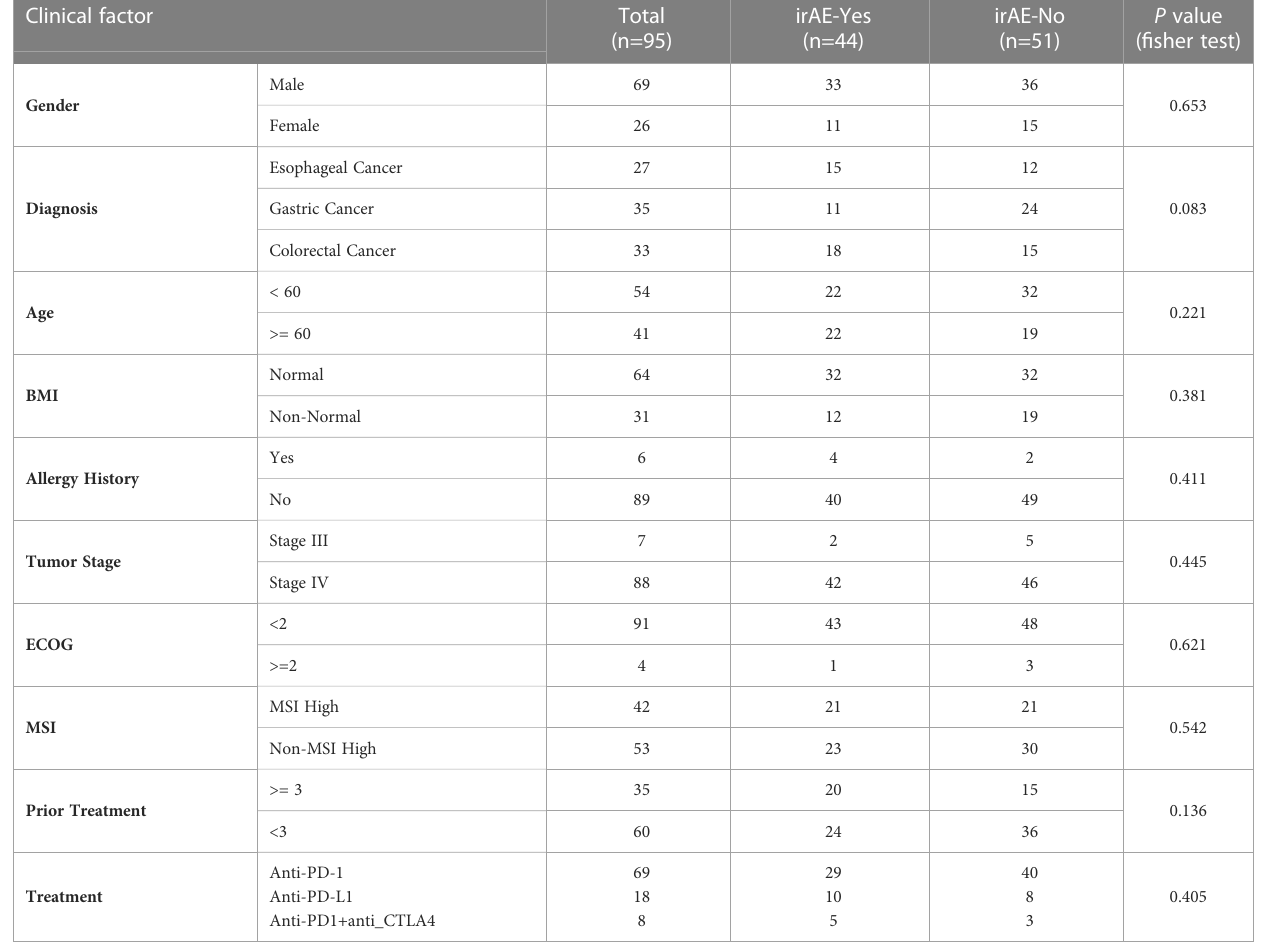
TABLE 1 Demographic and clinical information of enrolled patients. Clinical